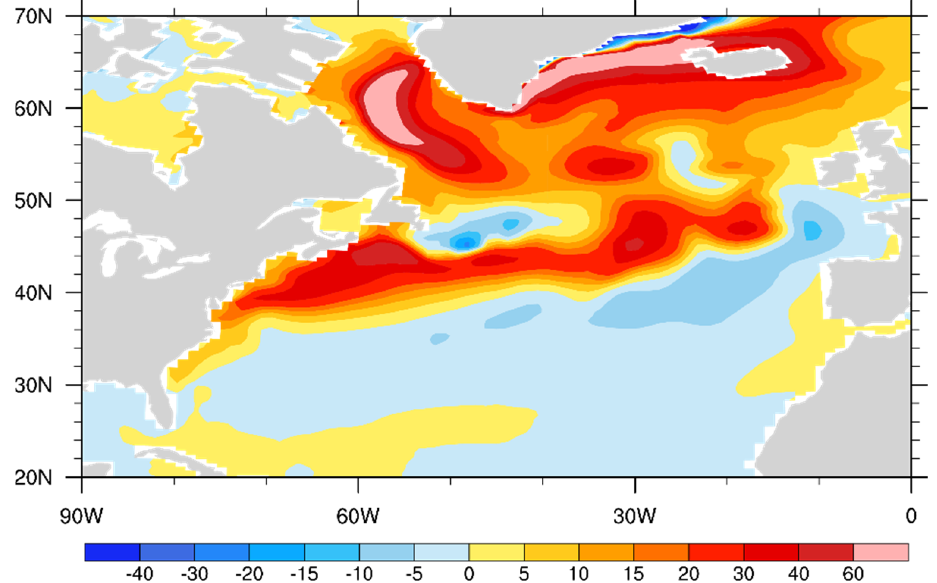
Figure 6. Net surface heat flux (Qnet) response to Arctic sea ice loss over the North Atlantic in FOM. A positive value indicates that the ocean gets energy. Qnet = SW–LW–LH–SH. Unit: W/m 2 .